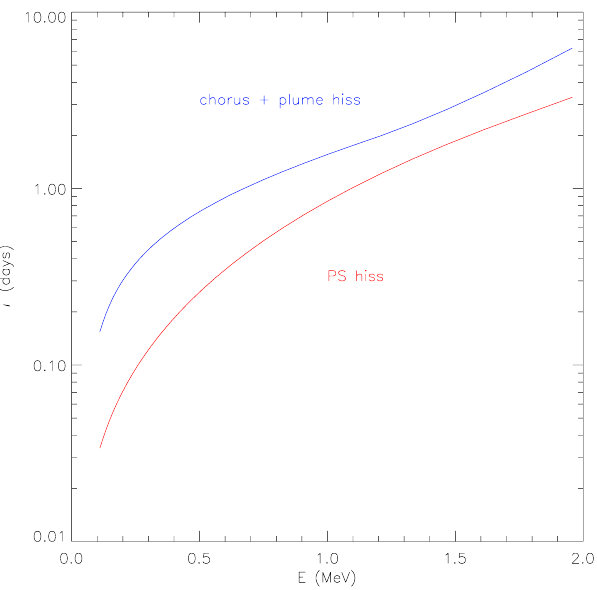
Figure 13. Decay timescales at L = 4 . 5 from a model of plasmas- pheric hiss (red), and from a combination of chorus waves and hiss in a plasmaspheric plume